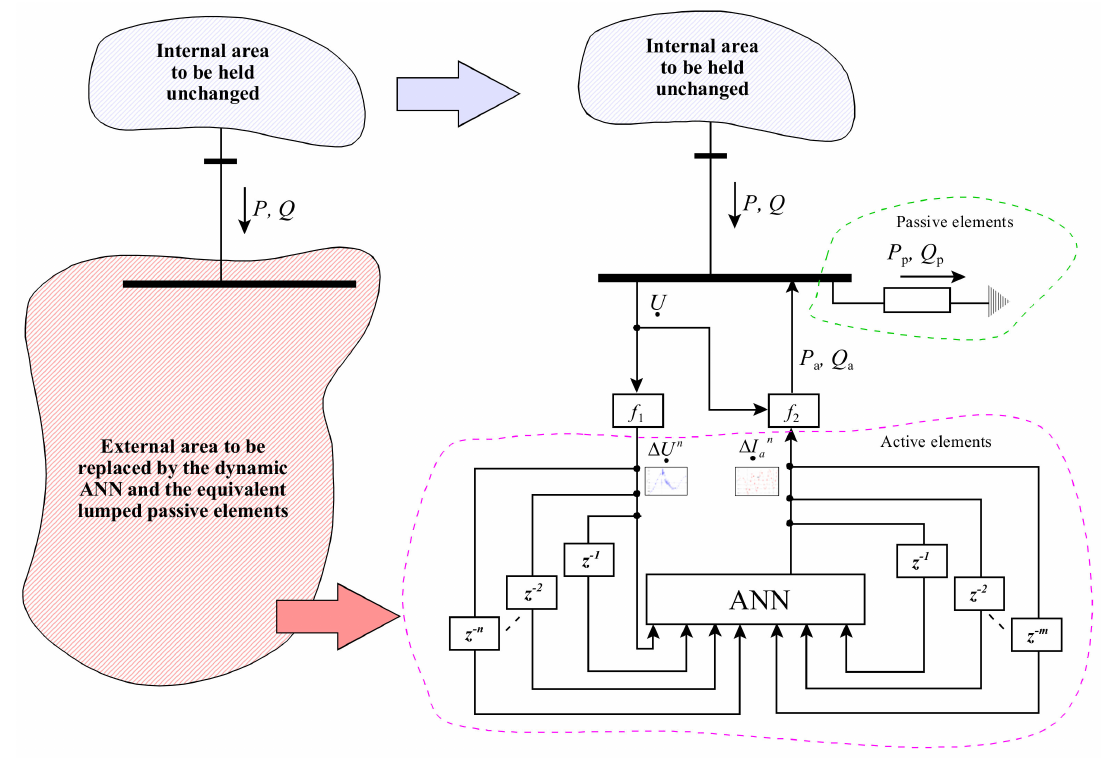
Figure 7. Principles of the proposed dynamic equivalencing